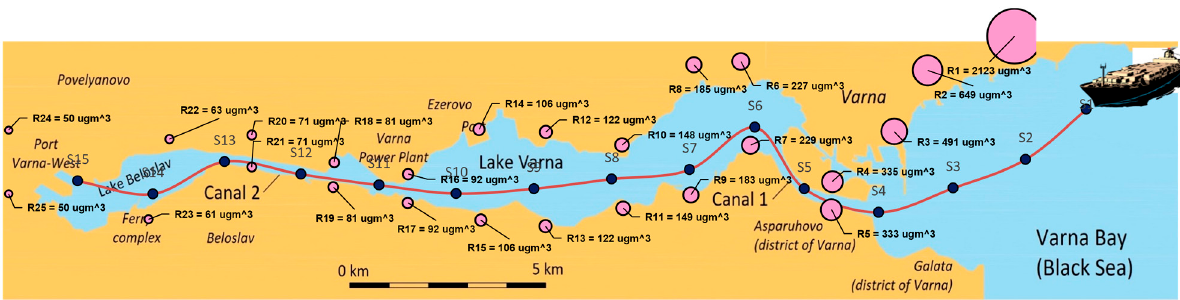
Figure 9. Air pollution, μ g/m 3 at receptors R 1 to R 25 , from ship sources S 1 to S 13 and queuing port and terminal, before ship emission reduction, NO x